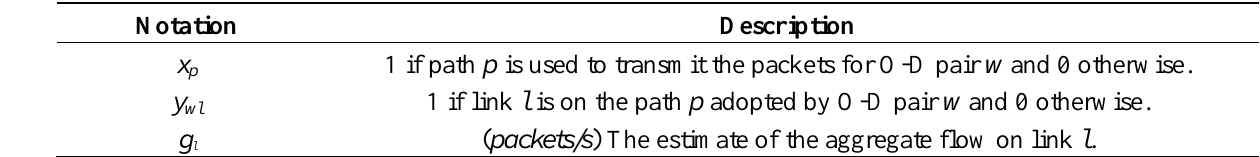
Table 3. Decision